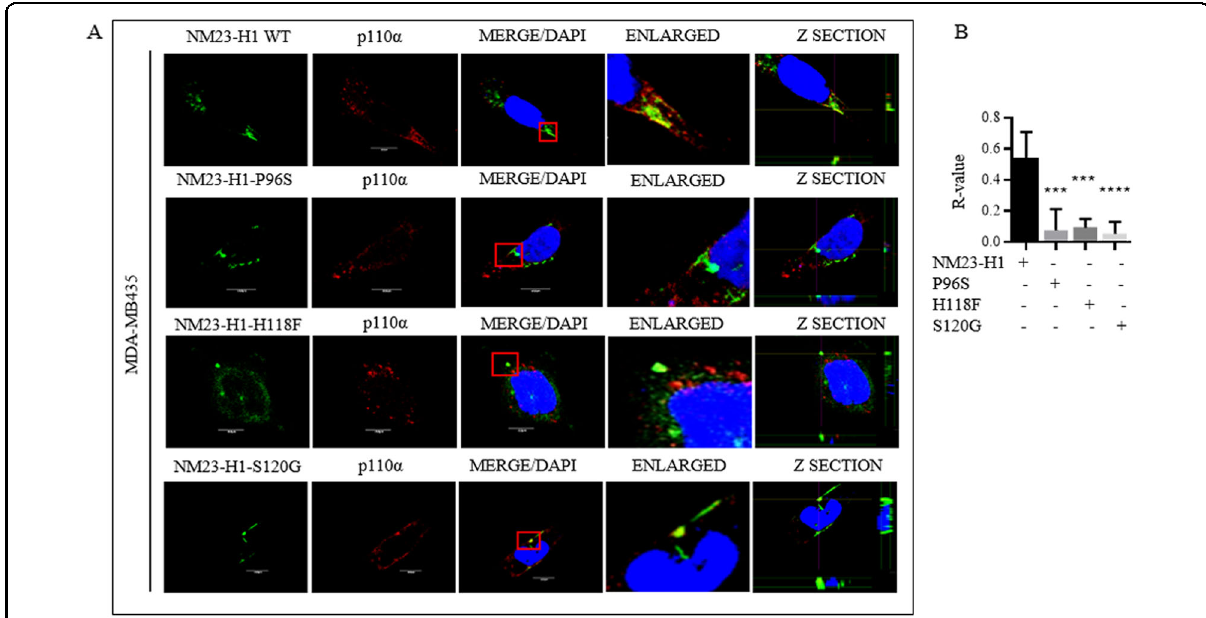
Fig. 2 p110 α co-localizes with NM23 ‐ H1 in MDA-MB-435 cell lines. A Cells were transfected with both HA-NM23 ‐ H1 and Myc-p110 α , or the NM23-H1 mutated isoforms HA-P96S, HA-H118F, HA-S120G constructs. Cells were fi xed in 4% PFA and screened for NM23-H1 and p110 α signals using the anti-HA antibody and anti-p110 α antibody, respectively. Proteins were detected with the green channel for NM23 ‐ H1, P96S, H118F, S120G, and the red channel for p110 α using a Fluoview confocal microscope. Nuclei were stained with 4 ′ ,6 ′ ‐ diamidino ‐ 2 ‐ phenylindole (DAPI, blue). Merged images were composed from three independently acquired images. Scale bar 10 μm. B R -value co-localization score was measured with ImageJ-NIH software (* p <